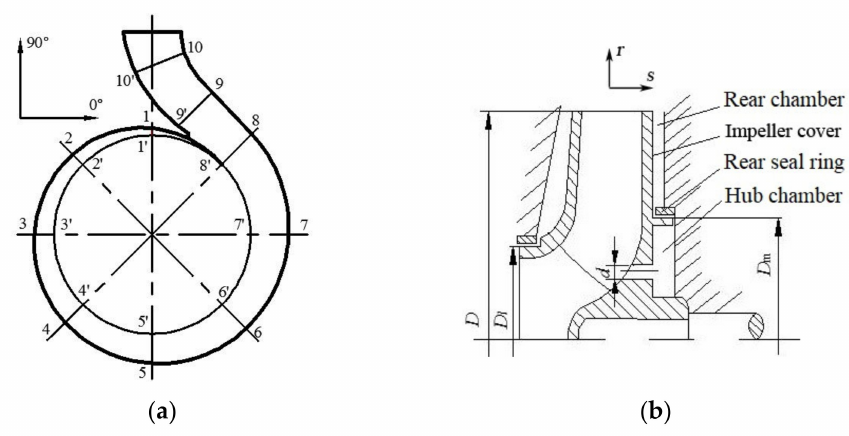
Figure 2. The calculation model diagram. ( a ) Planar graph; ( b ) axial plane